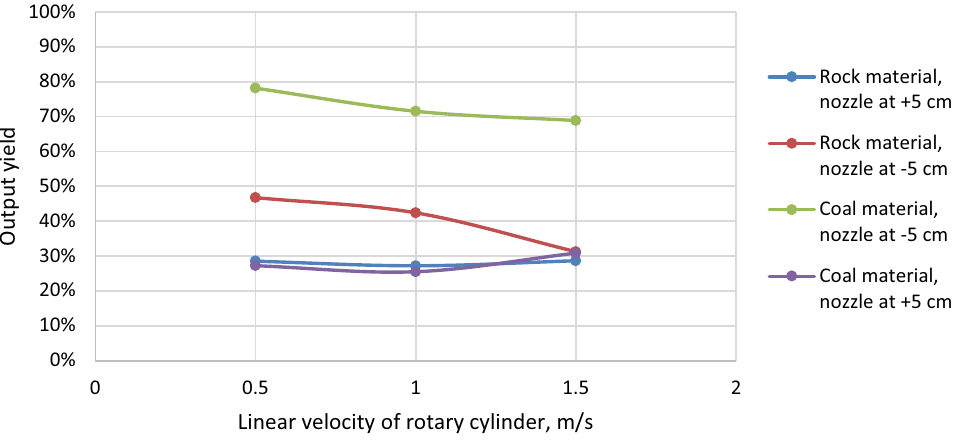
Fig. 7 Sucked-fraction output yield with respect to the linear velocity of the cylinder for different suction nozzle positions Table 7 Suction efficiency of grains with respect to the speed of the conveyor belt and the nozzle position Type of material